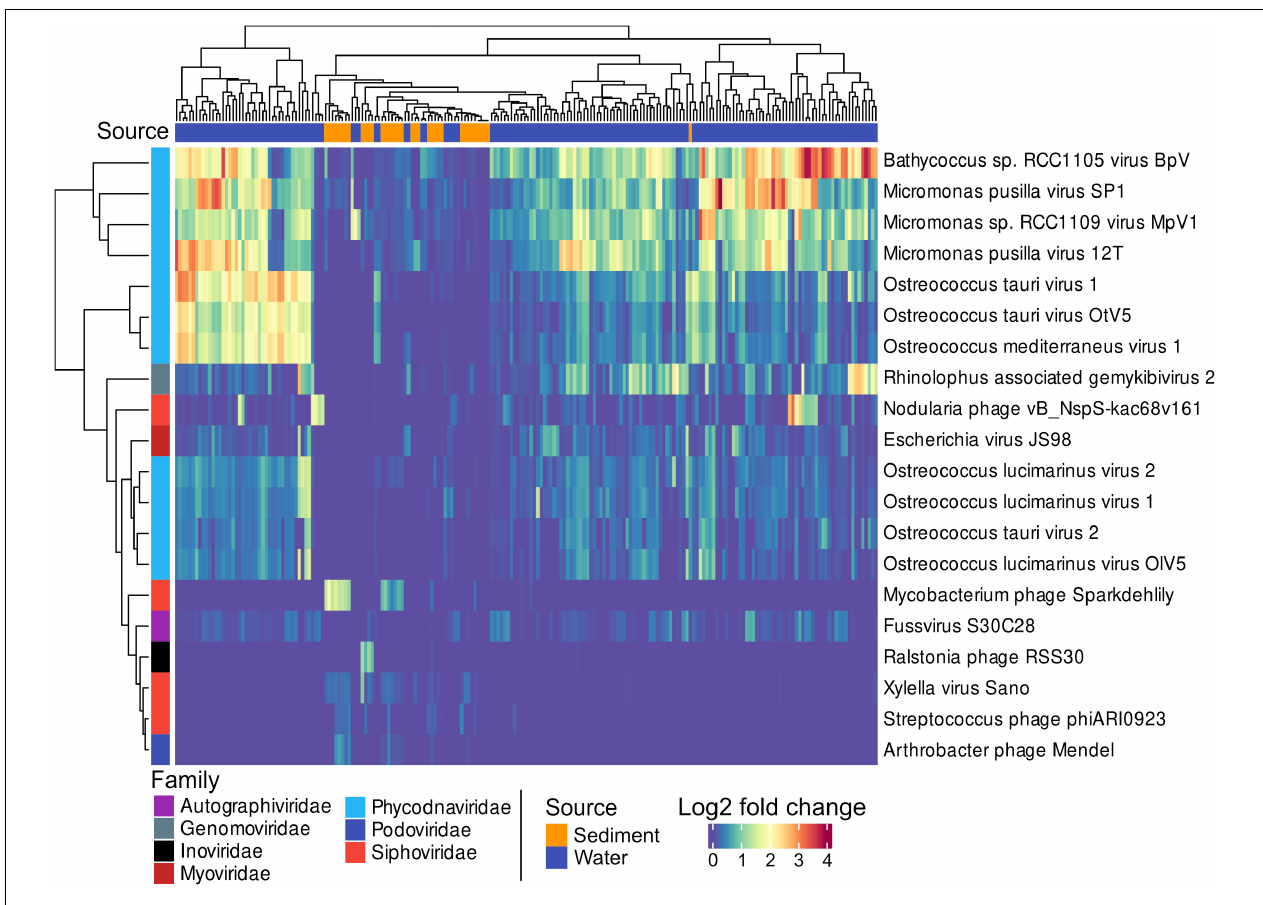
FIGURE 3 | A heatmap showing the 20 most significant, differentially abundant viral taxa between sediments and water samples. The Matrix was DESeq2 normalized showing the 20 most differentially abundant taxa with the smallest p .adj values ( < 0.0001 ). Sources of samples are indicated by blue or orange in the top color bar, and viral families by the color bar on the left